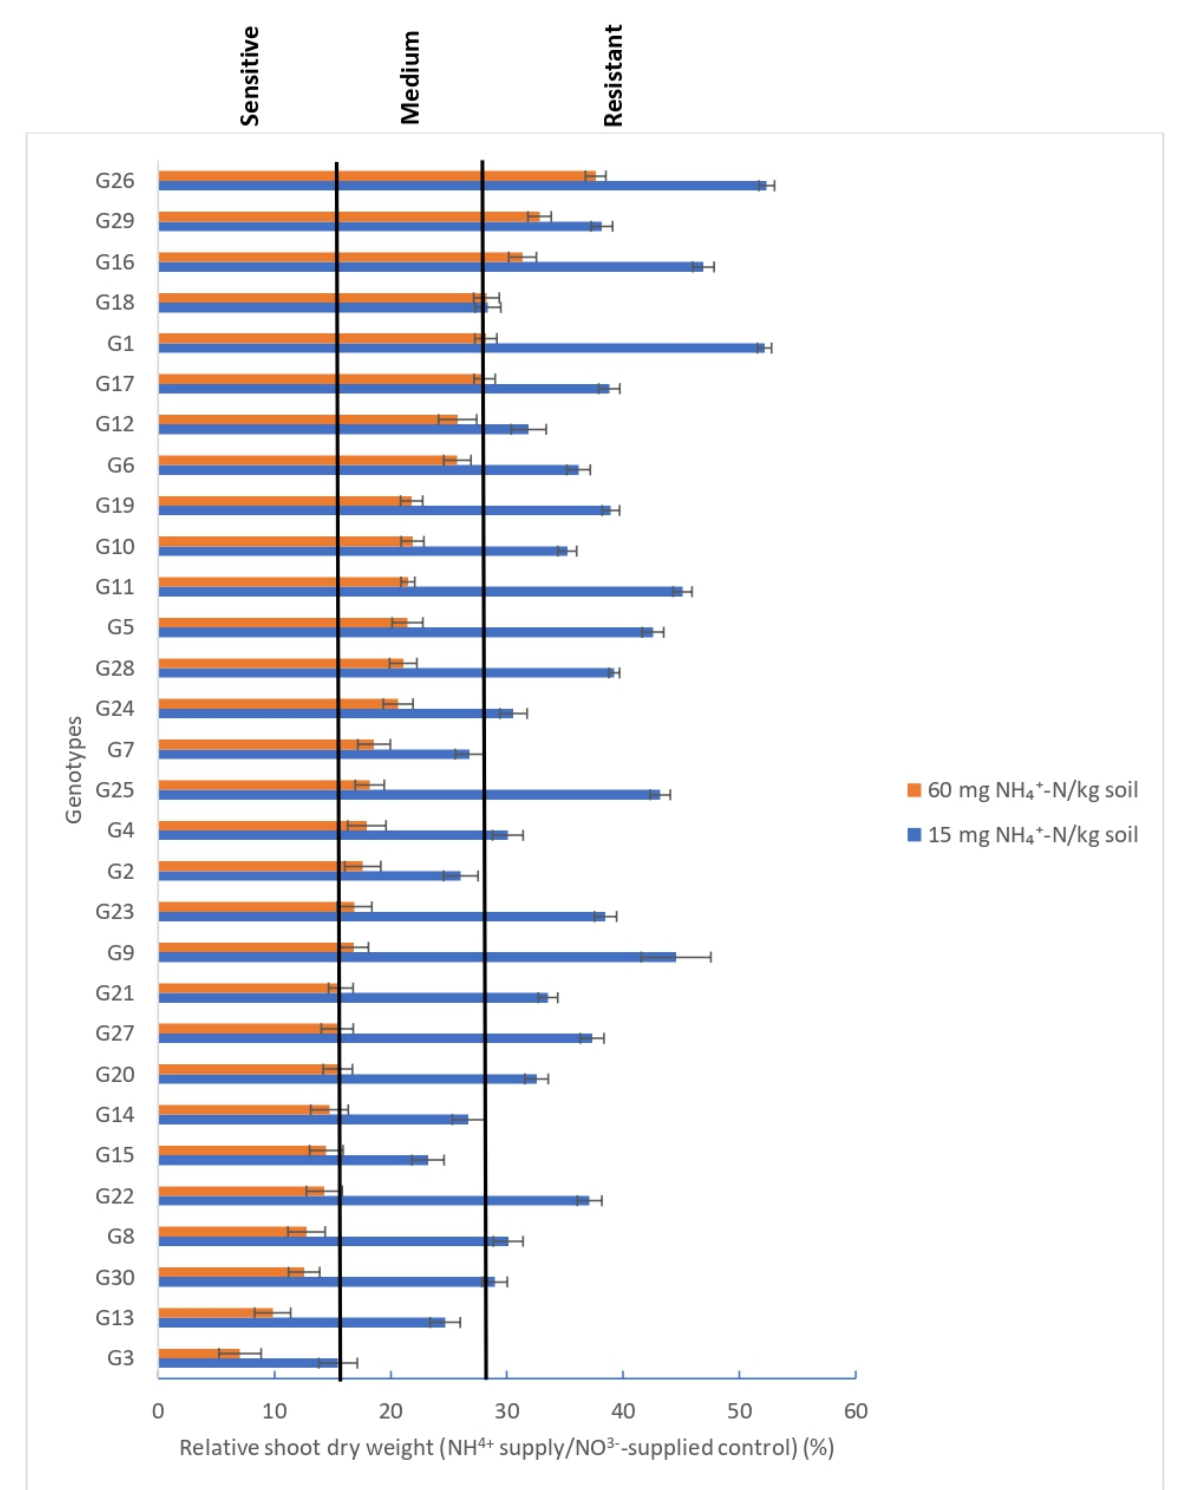
(Figure 6). Six genotypes (G20, G25, G7, G11, G5, and G2) showed negligible differences in shoot N concentration at the two NH 4+ -N rates.